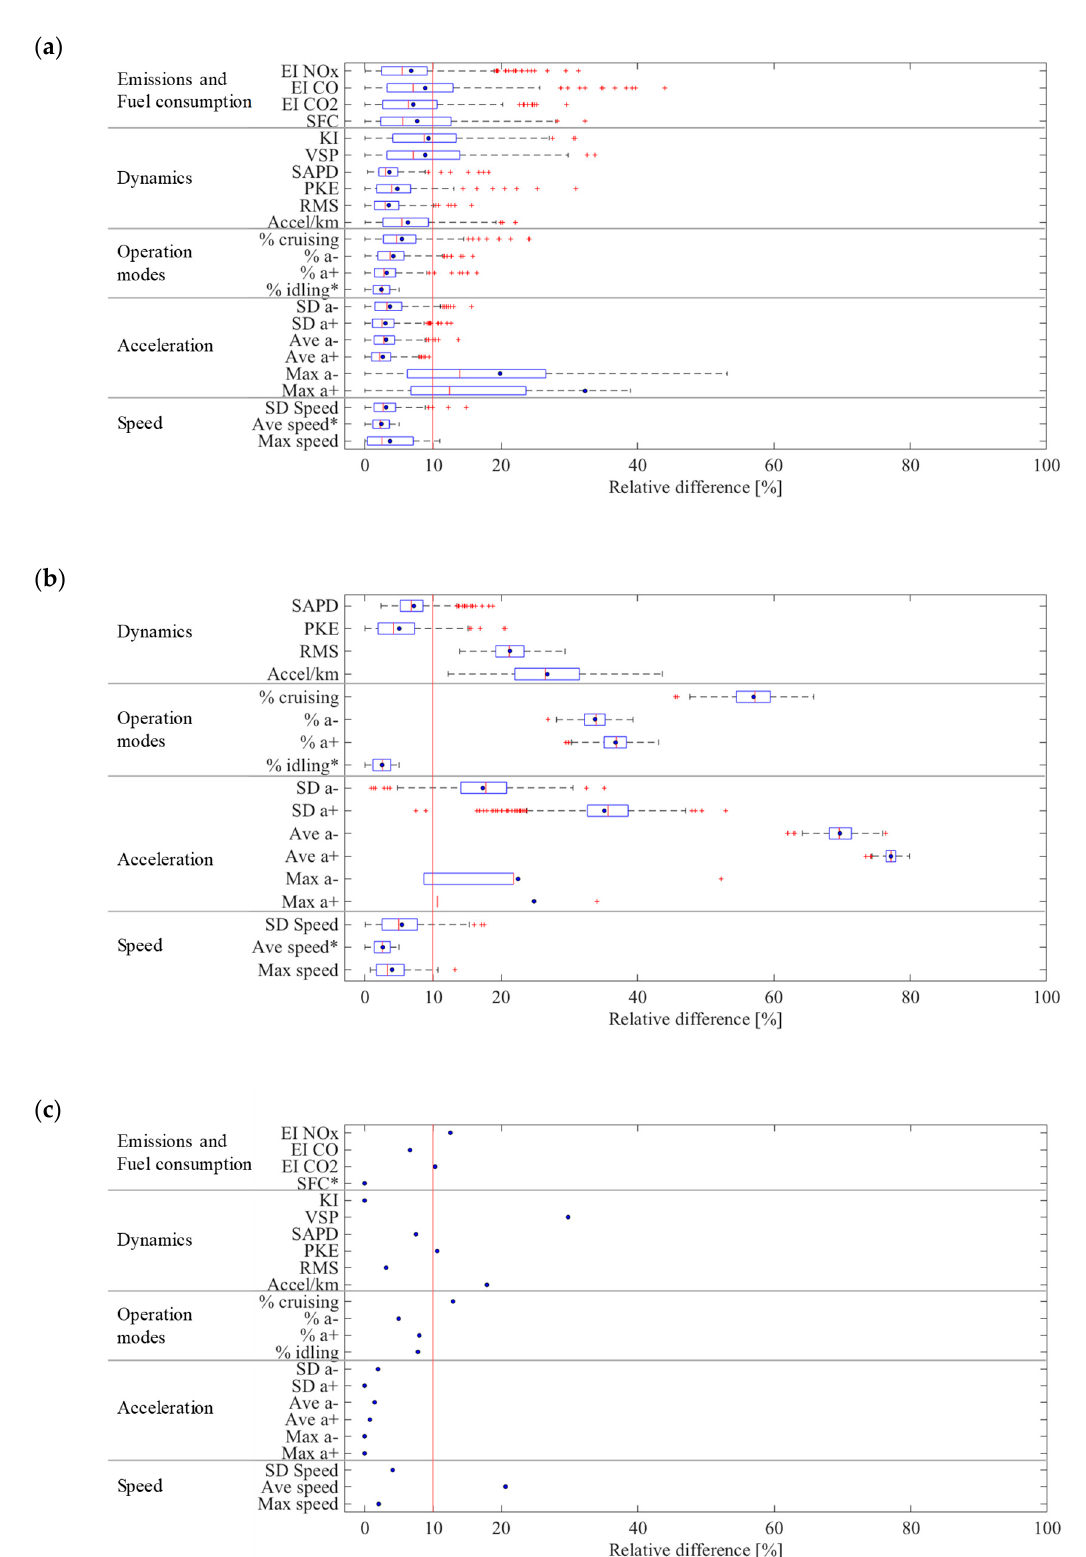
Figure 5. Boxplots of the relative differences ( RDi ) of the CPs that describe the DCs obtained by the ( a ) MT, ( b ) MCMC, and ( c ) FB methods in the general region after 500 iterations. The ARDi are shown as blue dots, the IQRi by boxes, and the outliers by red “+” signs. The CPs used by each method as criteria for the construction of the DC are marked with (*).